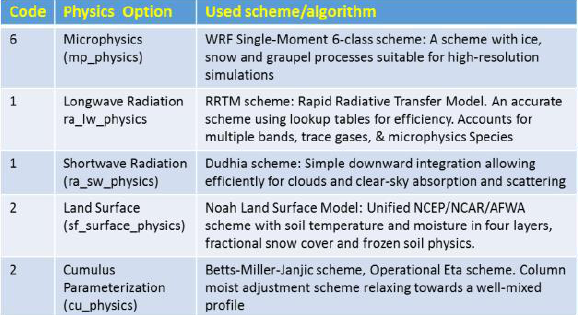
Figure 3: Domains for WRF simulations Table 1: WRF physics schemes used for simulations